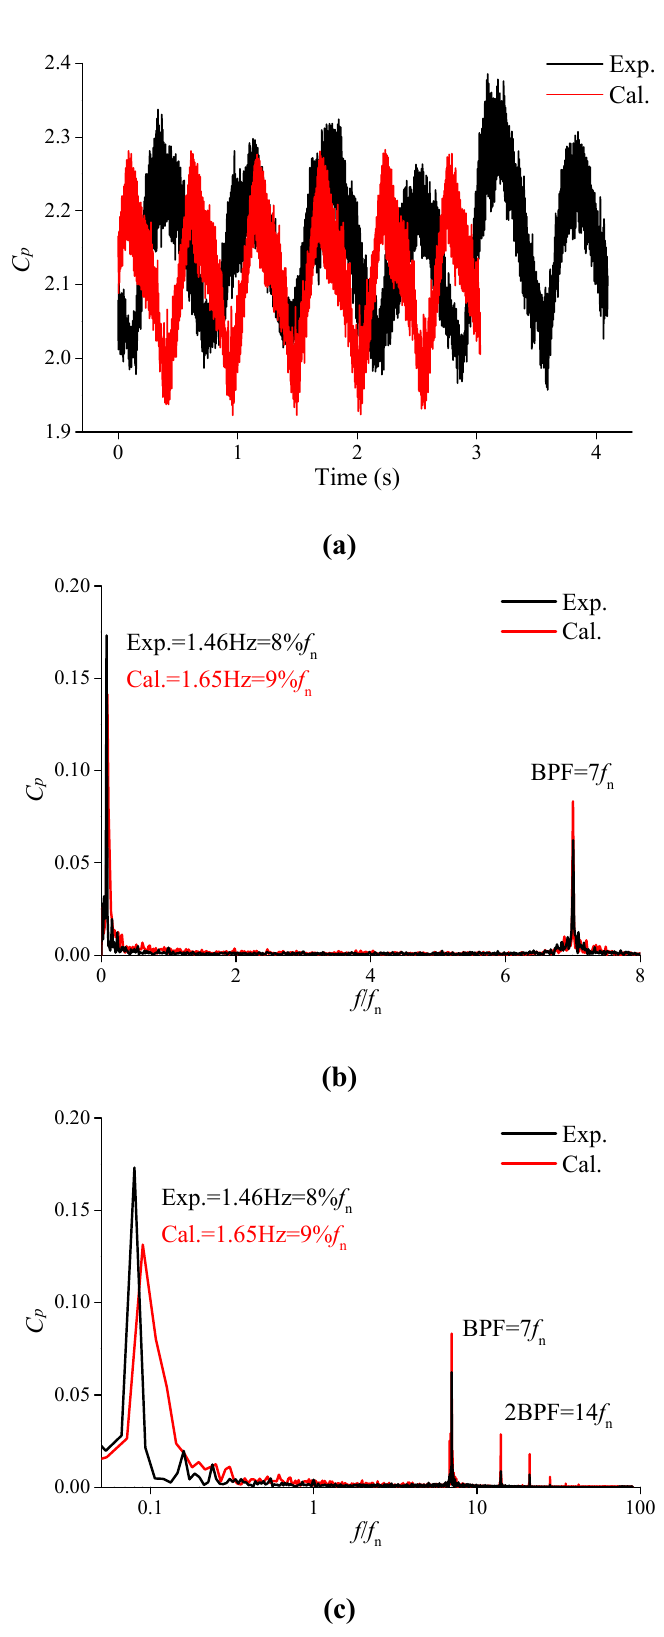
Figure 8. Pressure signals at vaneless space ( gv 1) at condition I. ( a ) Pressure fluctuations, and FFT (Fast Fourier Transform) results with ( b ) linear and ( c ) logarithmic abscissa.